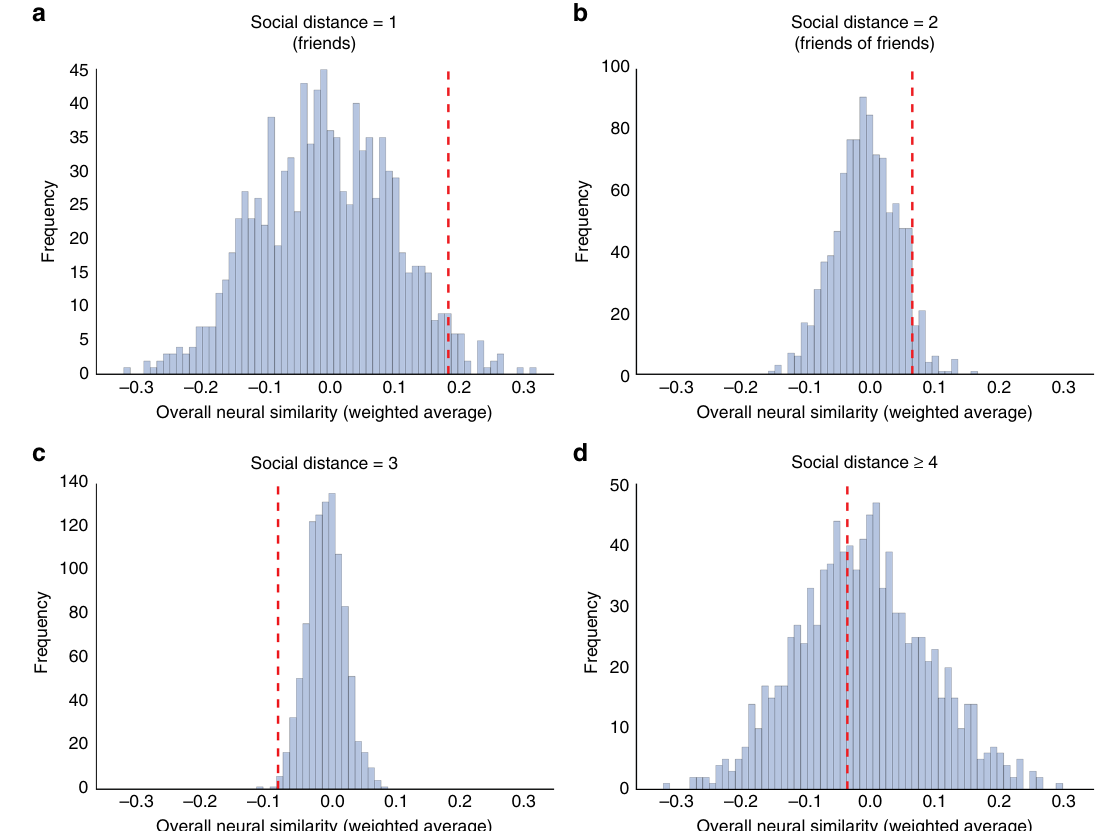
Fig. 7 Results of permutation testing based on network randomization. Histograms depict the distribution of average overall neural similarities for a distance 1, b distance 2, c distance 3, and d distance 4 dyads across 1000 permutations of the data set in which fMRI responses were randomly shuf fl ed across participants while the topological structure of the network of social connections between those participants was held constant. Red dashed lines depict the actual neural response similarities (i.e., based on the non-permuted data) for dyads corresponding to each social distance category. Results of these permutation tests indicated that distance 1 dyads ( N = 63) were more similar than would be expected based on chance ( p = 0.03), distance 2 dyads ( N = 286) were marginally more similar than would be expected based on chance ( p = 0.06), and distance 3 dyads ( N = 412) were less similar to